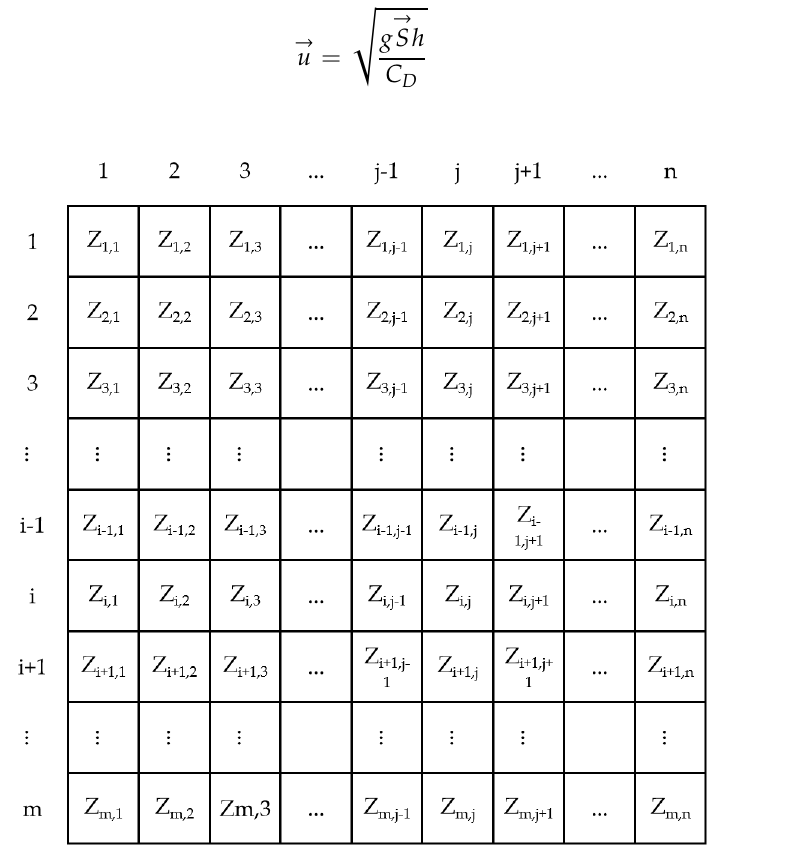
Figure 2. Schematic diagram of cells in the subcatchment Z.